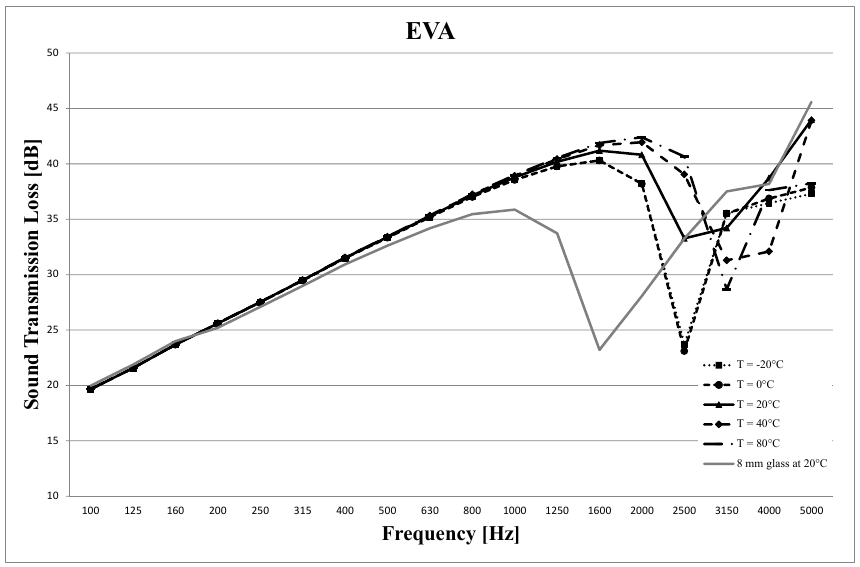
Fig. 17 Sound Transmission Loss Curves of glasses laminated with EVA at different temperatures Same trends as for the rigid PVB can be stated for the ionomer interlayer (see Fig. 18). Nevertheless, the dampening effect is not as significant as for the rigid PVB. It’s possible that additional temperature increase would lead to STL